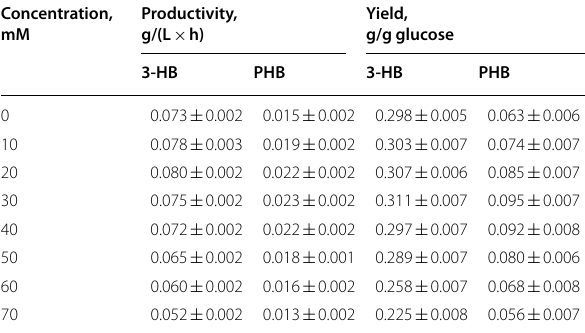
Table 2 The productivity and yield of 3-HB and PHB at